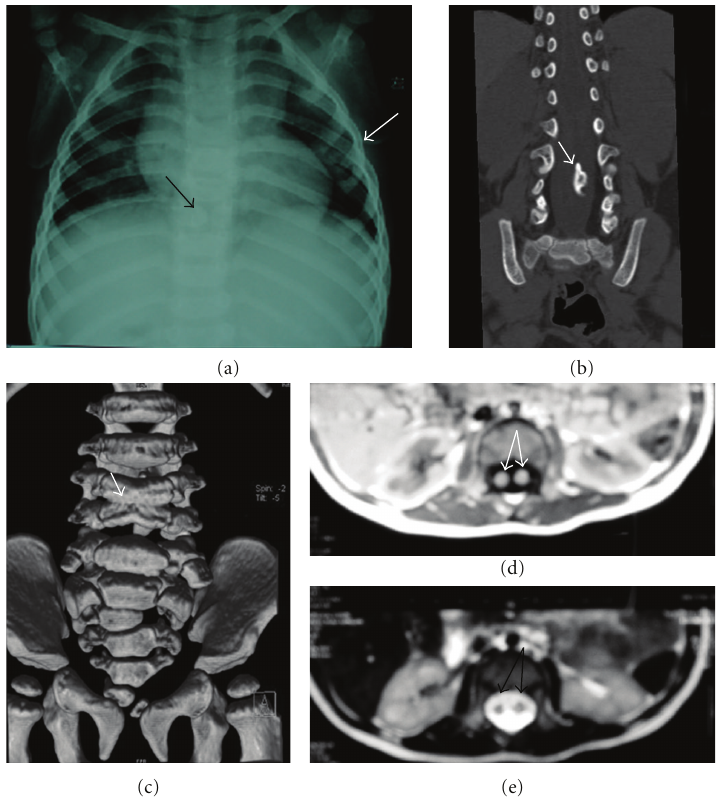
Figure 2: Plain radiographs revealed cleft vertebrae of the ninth thoracic vertebrae, and bifid rib of the fourth rib (Figure 2(a)). Computed tomography (CT) scans showed split cord malformations, block vertebrae of the third and fourth vertebrae, and hemivertebra of the second sacral vertebrae (Figures 2(b) and 2(c)). Magnetic resonance imaging (MRI) showed split cord malformations (Figure 2(d) and 2(e)).